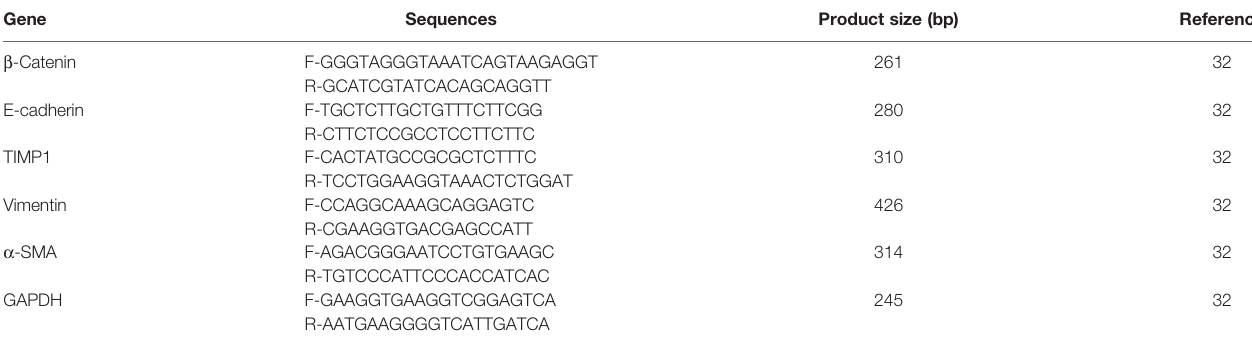
TABLE 1 | Primers used for real-time PCR assay in this